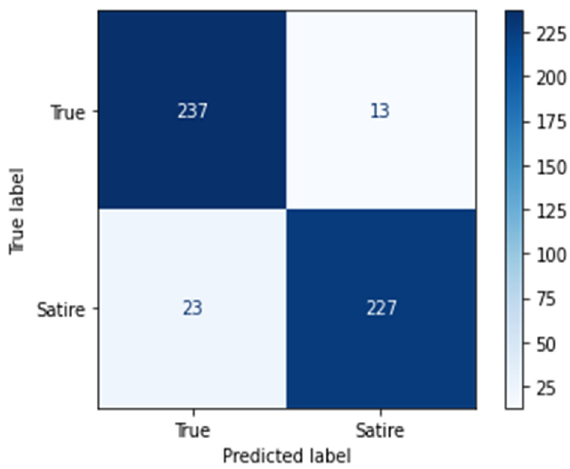
Figure 12. Confusion matrix for Twitter dataset.